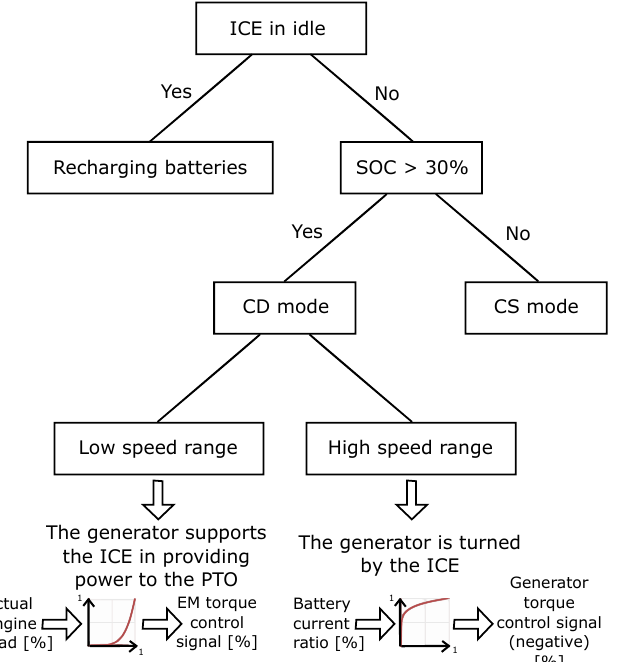
Figure 14. The control strategy of the parallel hybrid and electro-hydraulic hybrid